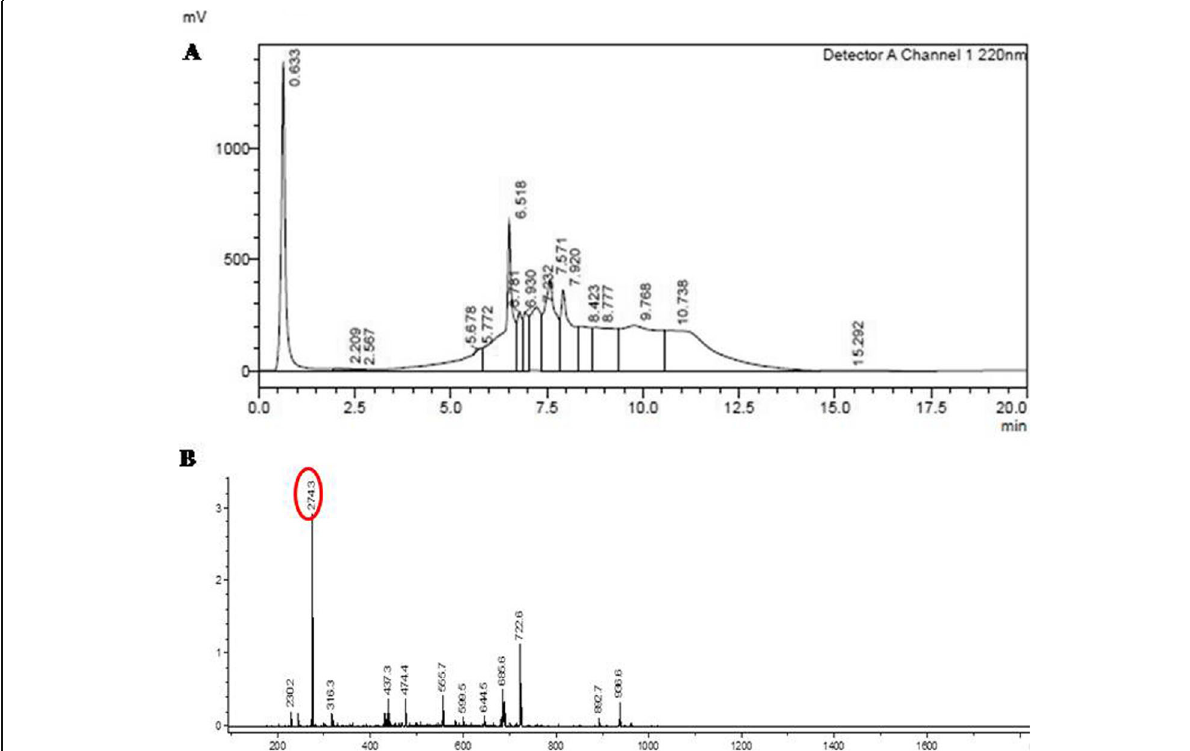
Fig. 2 Analysis of CF4 fraction by HPLC. a The HPLC chromatogram of the fraction CF4. b Mass spectrum of the HPLC purified eluent at RT 6.5-6.6